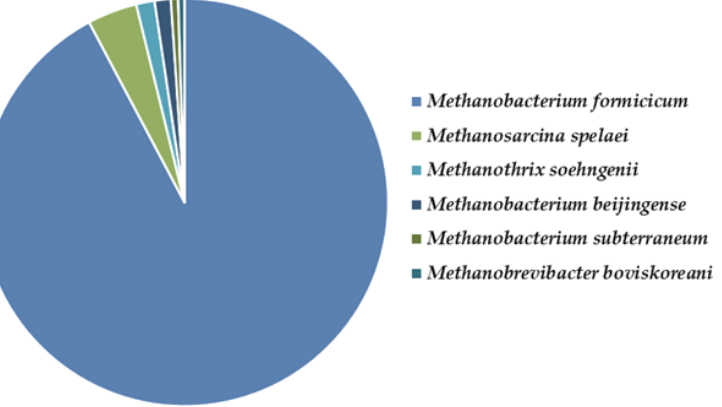
Figure 12. Archaeal biodiversity in the methane-producing microbial consortium. The ratio between archaeal species is presented.